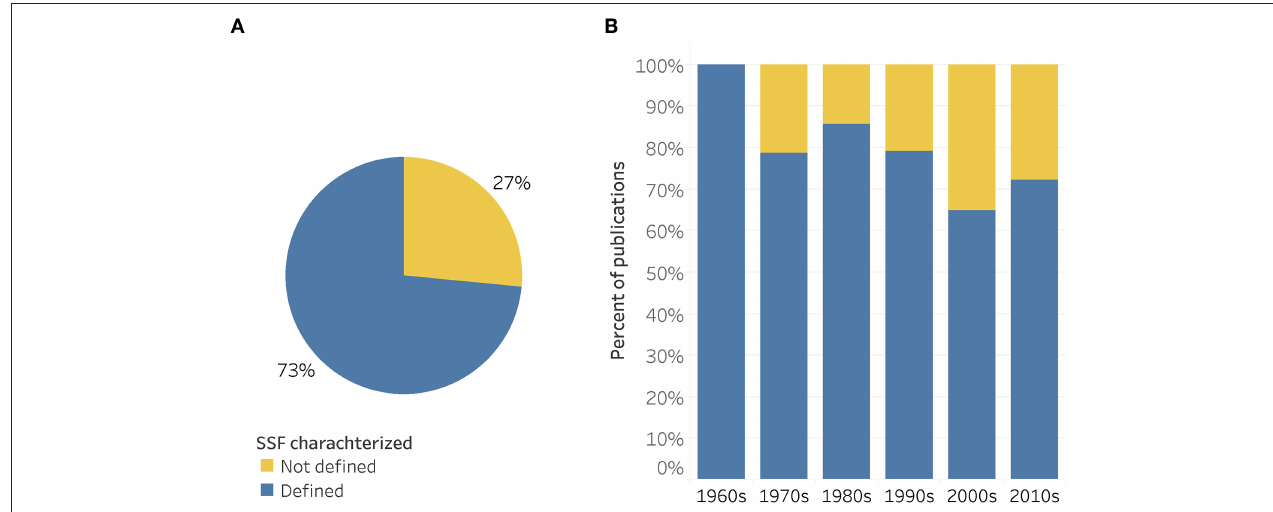
FIGURE 1 | The percentage of articles that provided a definition for small-scale fisheries for the total sample studied (A) and by the decade of publication (B) .